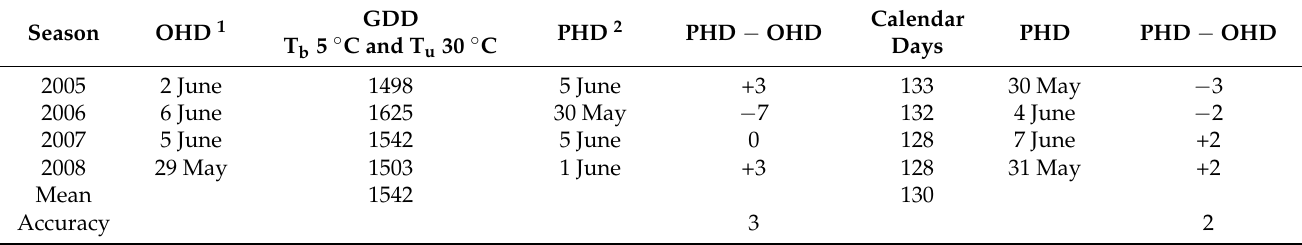
Table 4. Accuracy in harvest date forecasting for “Flame Seedless” table grape cultivated under greenhouse, based on GDD vs. the calendar day